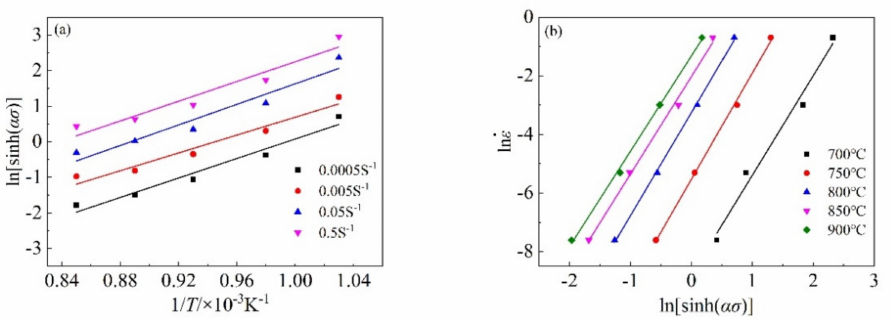
Figure 7. Relationship between flow stress and thermal deformation parameters of Ti-6Mo-5V-3Al- 2Fe alloy at strain 0.7 ∂ lnsinh ( ασ ) - ∂ 1/ T curve ( a ) and ∂ ln